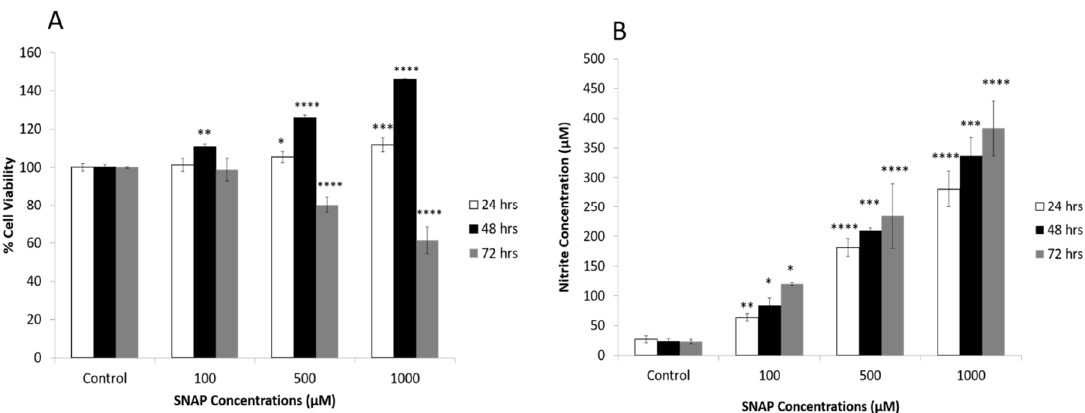
Figure 7. Effects of nitric oxide (NO) on the survival of the PDGFR α -positive cells. ( A ). NO donor, SNAP, increased the survival rate of the differentiated PDGFR α -positive cells significantly as compared to the control condition. This response was concentration- and duration-dependent for 24 and 48 h. Reduction in the survival rate of PDGFR α -positive cells was observed in response to treatment with SNAP for a longer duration (72 h). ( B ). Treatment of PDGFR α -positive with SNAP produced a significant increase in the level of nitrite in a concentration- and duration-dependent manner ( n = 3, * p < 0.05, ** p < 0.01, *** p < 0.001, **** p < 0.0001).